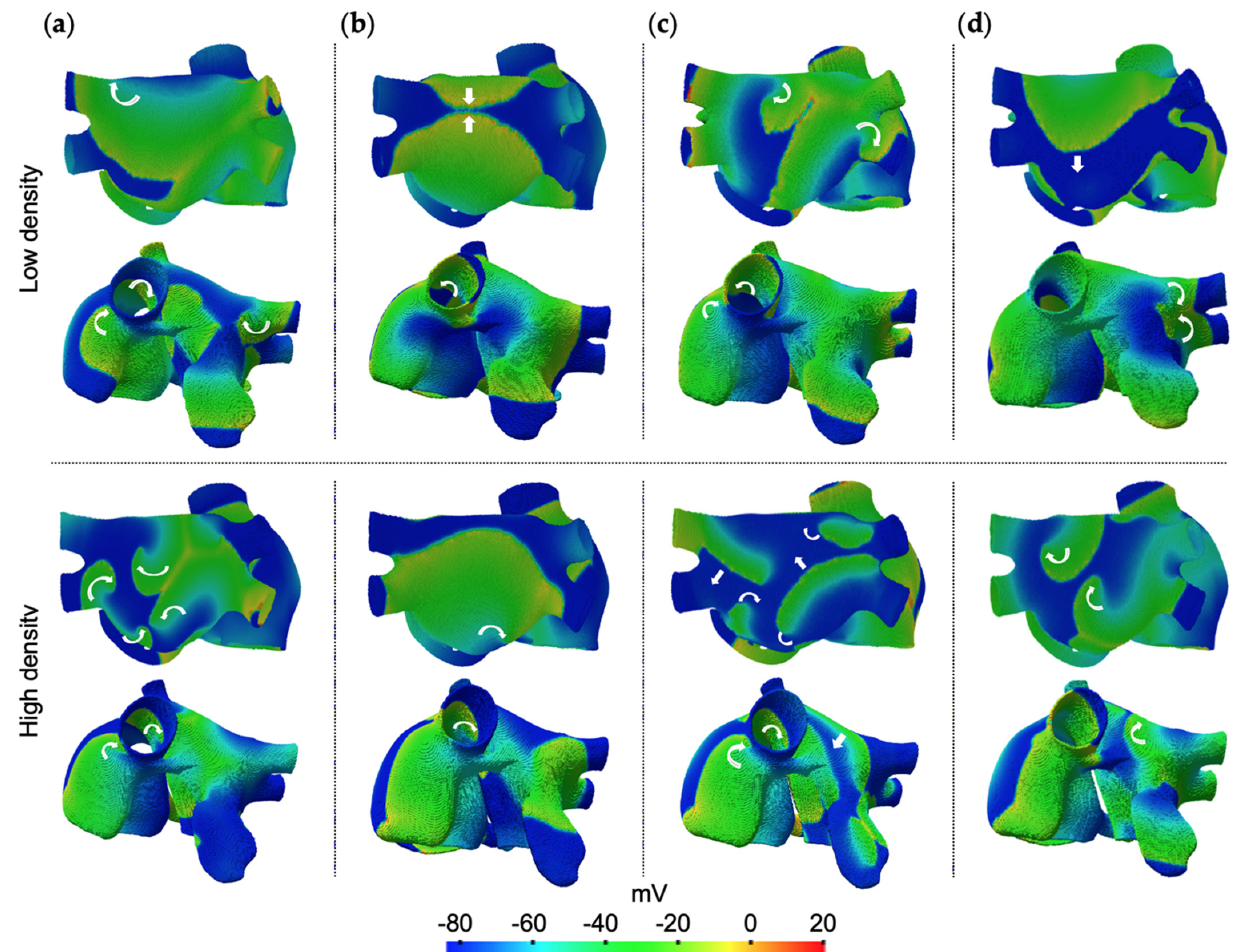
Figure 3. AF simulations with diffuse fibrosis at low (top) and high (bottom) density, for the follow configurations: ( a ) fibroblasts, ( b ) myofibroblasts, ( c ) fibrocytes, ( d ) fibroblasts + myofibroblasts + fibrocytes. White arrows show the direction of waves propagation.